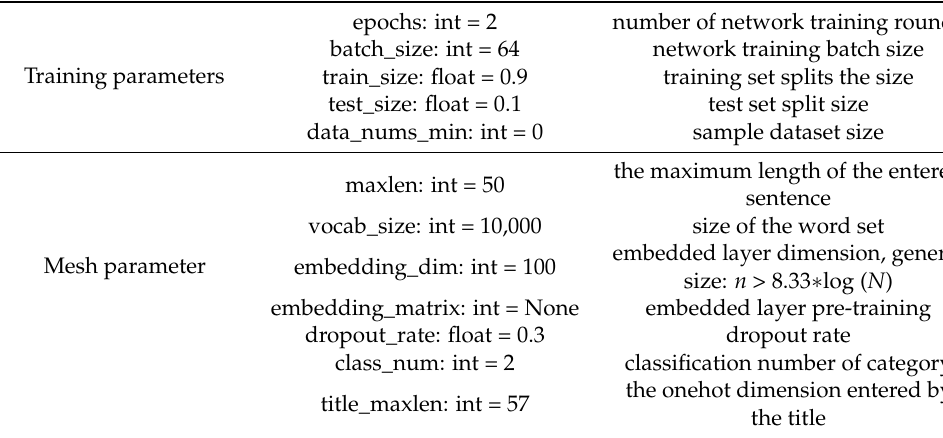
Table 5. Experimental Model Parameters.